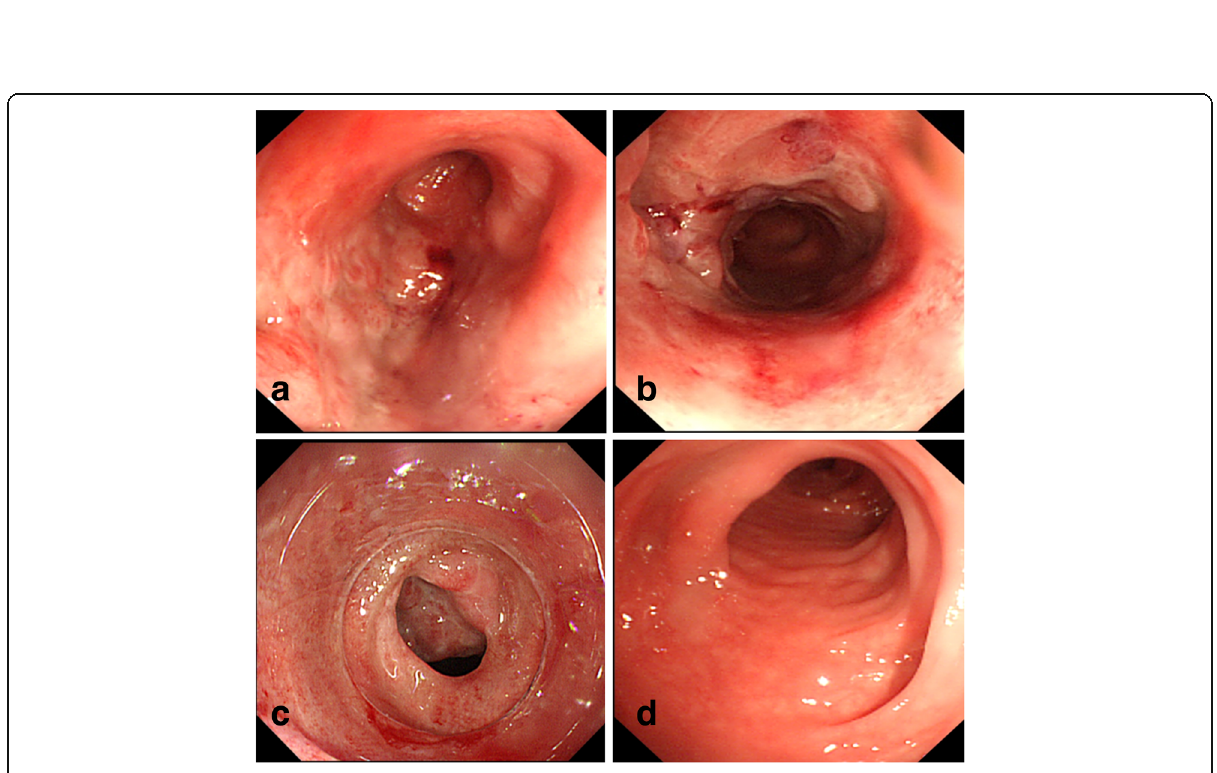
Fig. 3 Postoperative colonoscopic findings. On the 60th postoperative day, colonoscopy revealed bowel stenosis with ulceration in the ascending colon ( a ) and the rectum ( b , c ). The patency was 5mm in diameter at both strictures. Colonoscopy showed normal luminal findings through the transverse colon ( d ) to the sigmoid